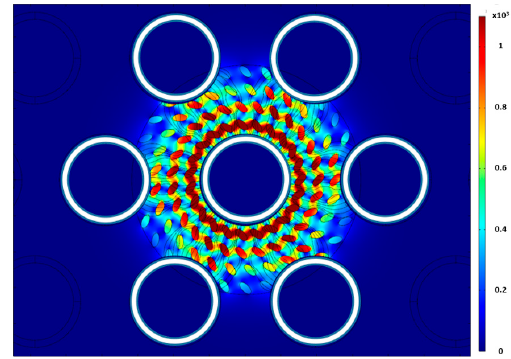
Figure 15. Electric field distribution for ( a ) Arrangement 1 and ( b ) Arrangement 2.